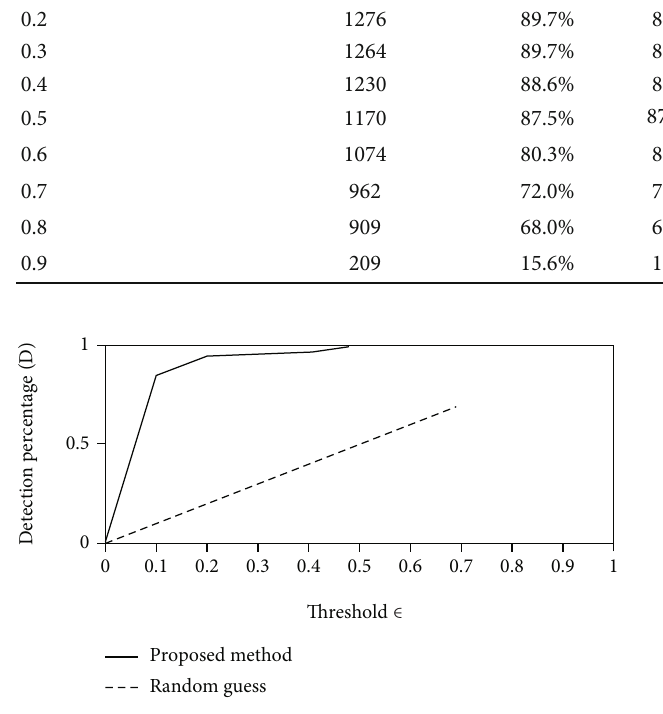
Figure 13: Detection percentage ( D )